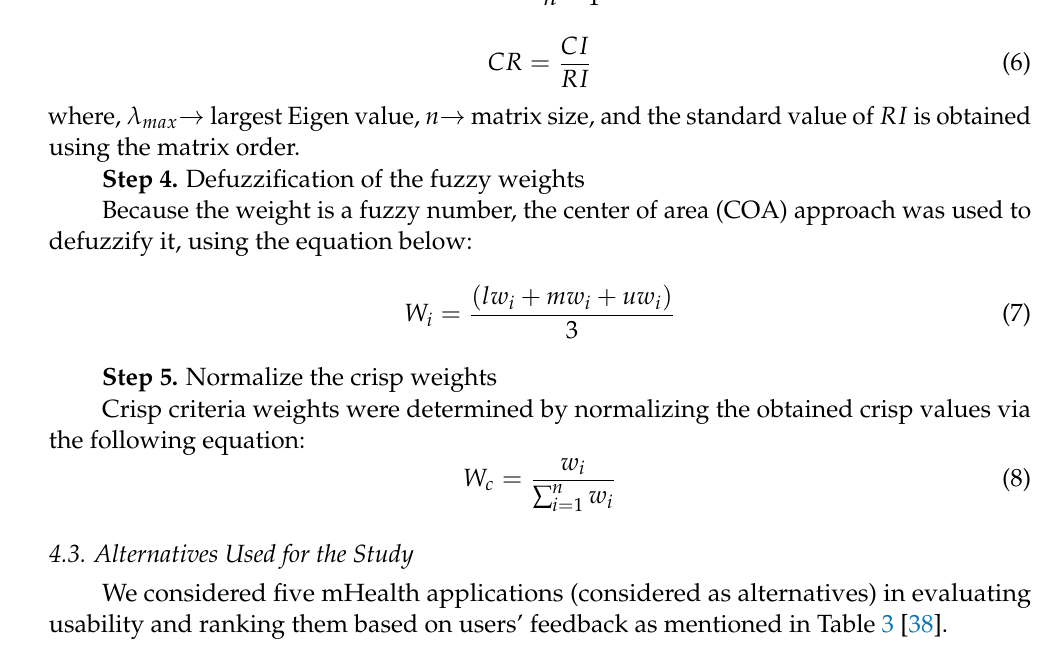
Table 3. Alternatives for the system under